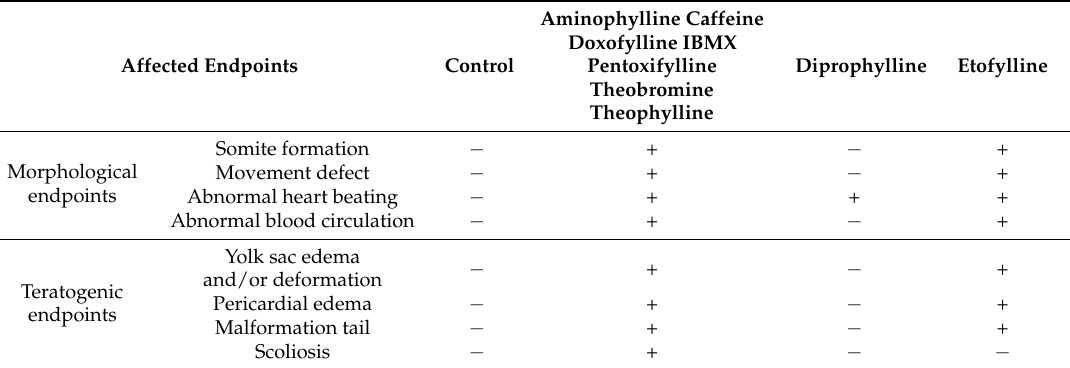
Table 3. Specific developmental and teratogenicity endpoints affected by